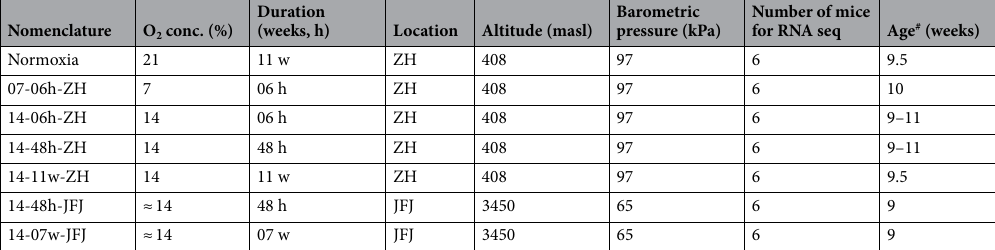
Table 1. Experimental groups. masl: meter above sea level; ZH: Zürich; JFJ: Jungfraujoch high-altitude research station; # age at the beginning of the